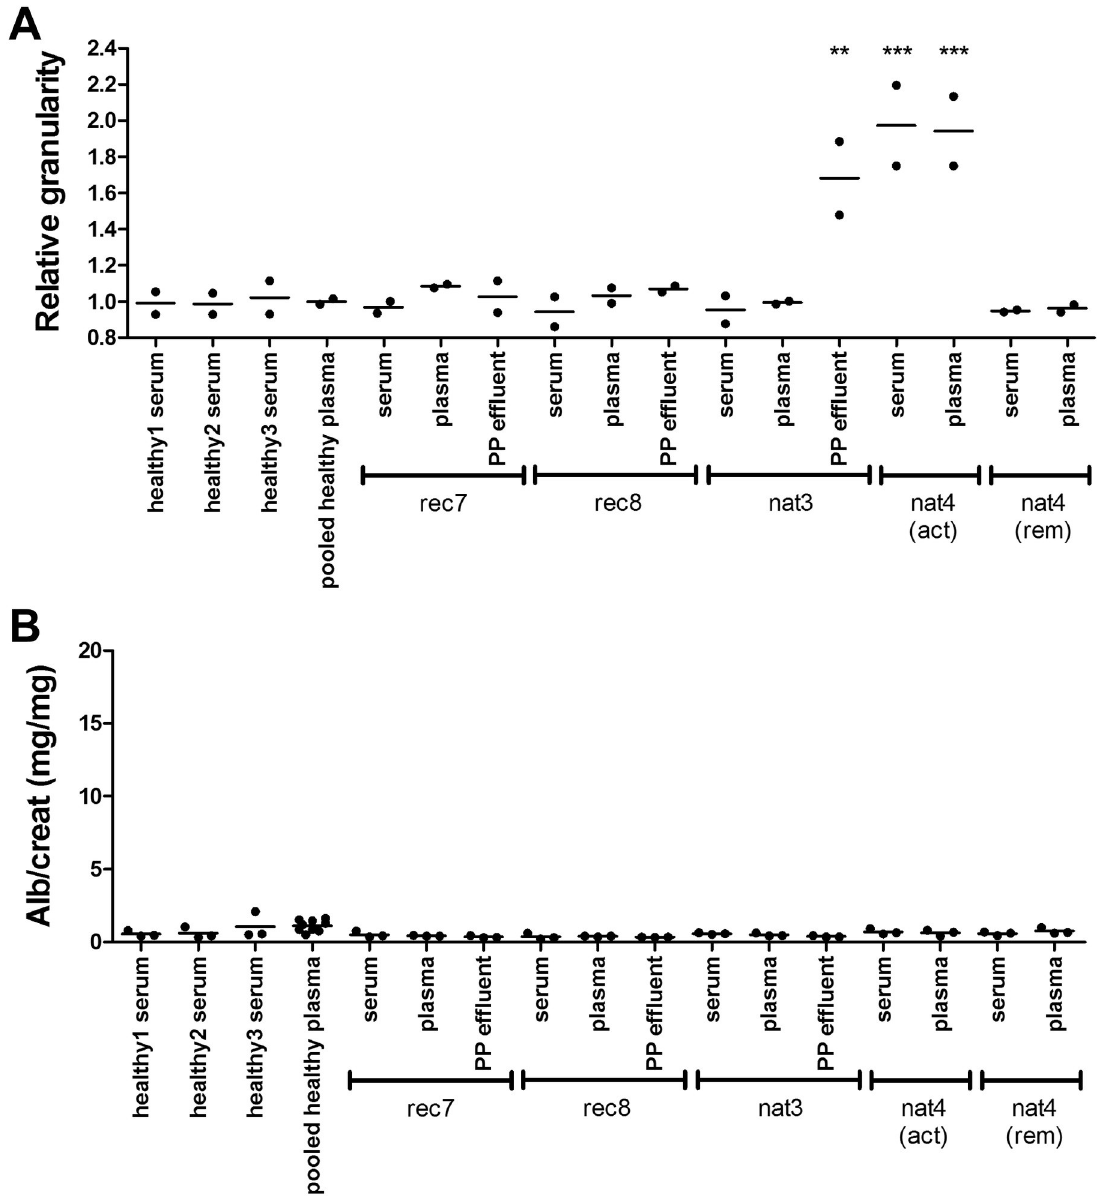
Fig 4. In vitro and in vivo responses to simultaneously collected serum, plasma, and PP effluent. ( A ) Cellular granularity of cultured human podocytes (hPod) exposed to simultaneously collected serum, plasma, and PP effluent, as measured by flow cytometry, is represented by the median side scatter relative to healthy controls. Relative granularity of two replicate experiments and their mean are presented. �� p < 0.01, ��� p < 0.001 versus pooled plasma from five healthy donors for (PP) plasma and versus three healthy donor sera for sera. ( B ) Albuminuria of Balb/c Thy-1.1 males injected intravenously, at 5 weeks ± 3 days old, with 2 mg protein from serum, plasma, or PP effluent from three FSGS patients during active disease (rec7, rec8, nat3) and serum and plasma from one FSGS patient not treated with PP, during active disease and remission (nat4). Individual animal data and group means of urinary albumin/creatinine (alb/creat, mg/mg) ratio are presented. Data of healthy donor sera derived from Fig 3 and pooled healthy plasma derived from Fig 1 are shown for comparison with patient samples. Although none of the patient sera induced proteinuria, the ages of the patients in this study do not match the ages of the healthy donors, which may limit interpretation of these data.